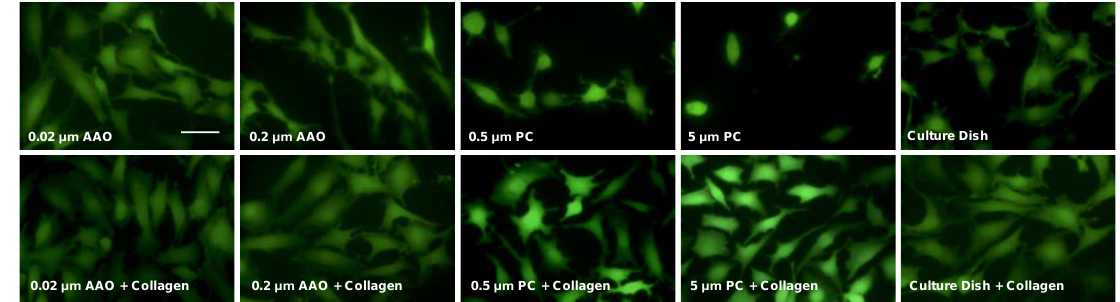
Figure 3. Podocytes incubated at 33 °C for 48 h. The images were taken by fluorescence microscopy. Scale bar, 5 μm.